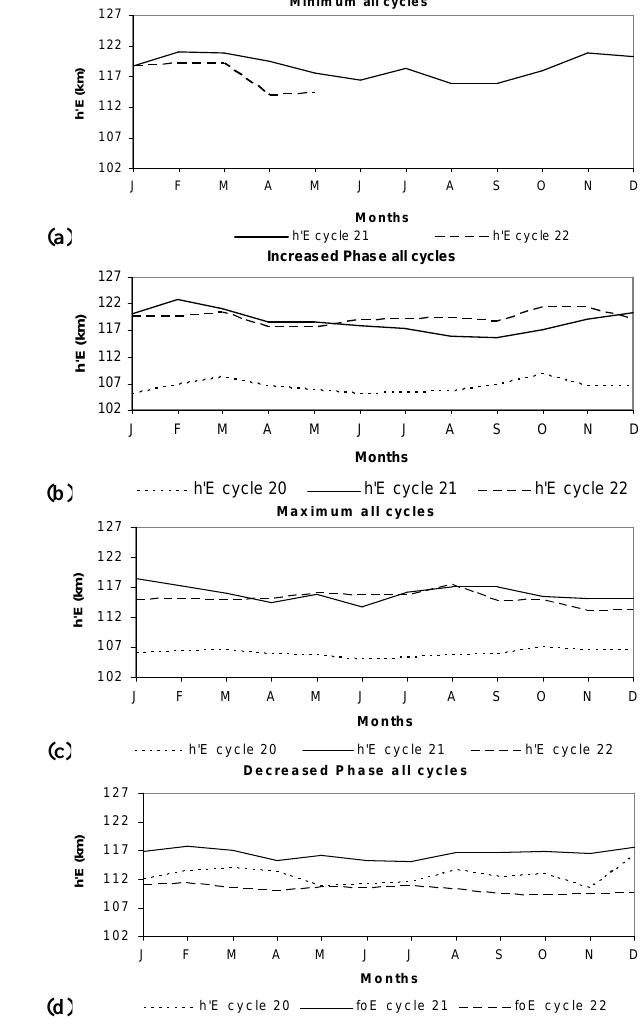
Fig. 6. Similar to Fig. 3 for h 0 F2.